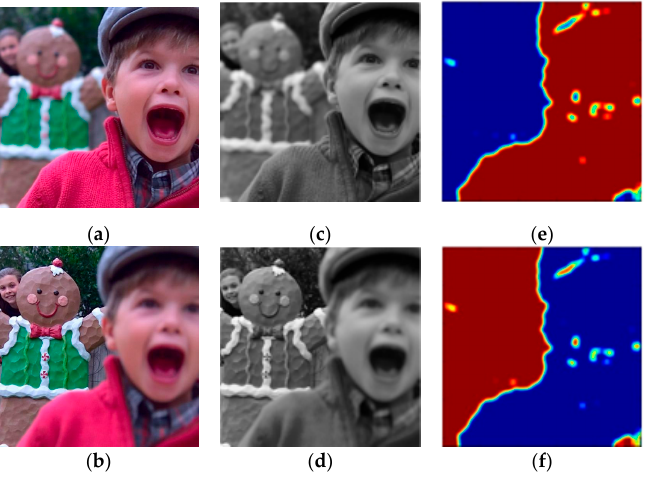
I ; ( d ) low-scale image I LL A A A S . B